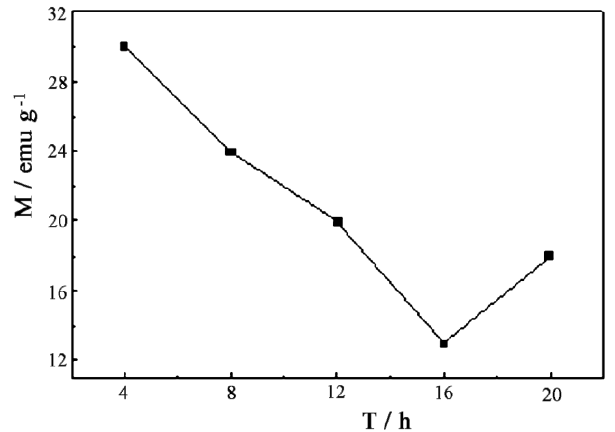
Figure 7. The magnetic hysteresis plots for γ-Fe 2 O 3 /PANI /curcumin under the different reaction time: a, 4 h; b, 8 h; c, 12 h; d, 16 h and e, 20 h.